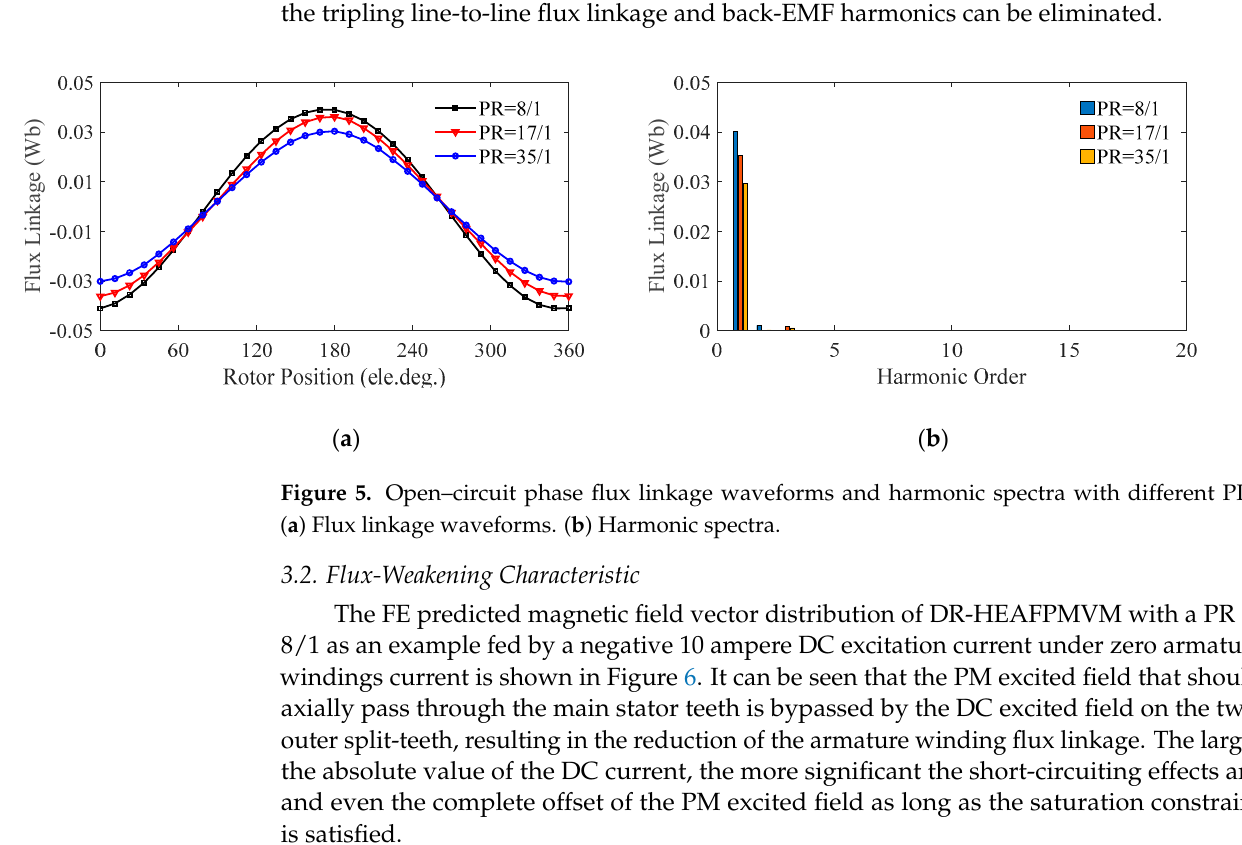
Figure 4. Open–circuit air–gap flux density waveforms and harmonic spectra with different PRs. ( a ) PR of 8/1. ( b ) PR of 17/1. ( c ) PR of 35/1.